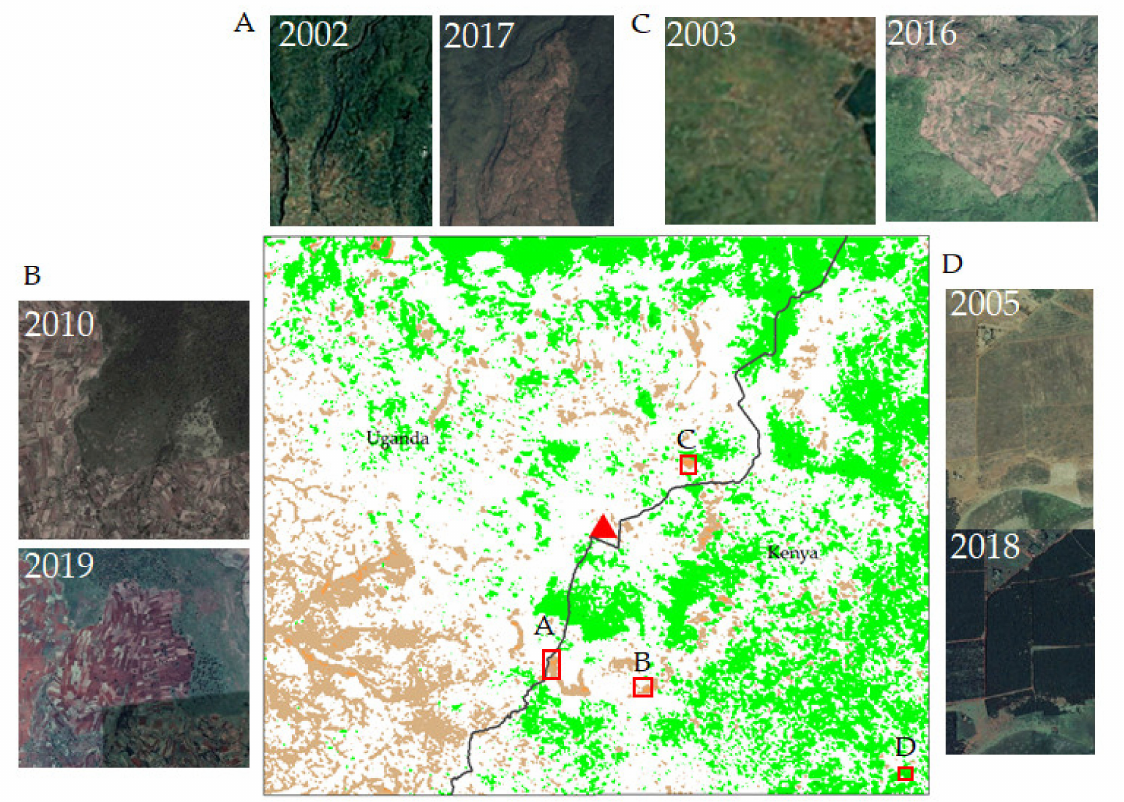
Figure 15. ( A – D ) Some of the greened and browned areas identified by Mann–Kendall and Sen’s slope. Images ( A – C ) indicate the conversion of natural vegetation (mostly forest) to cropland and settlement. Image ( D ) indicates a ff orestation. Source: Google Earth Pro